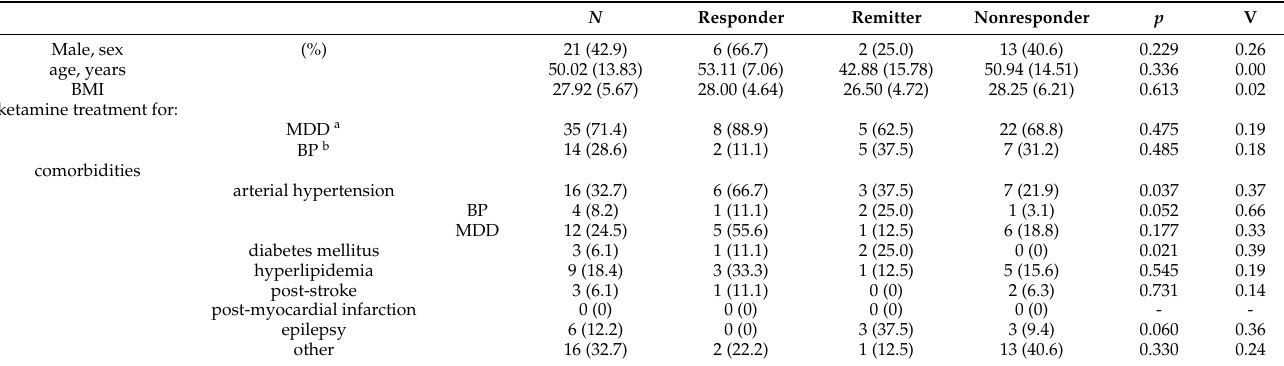
Table 1. Demographic and clinical characteristics of the study population is presented.